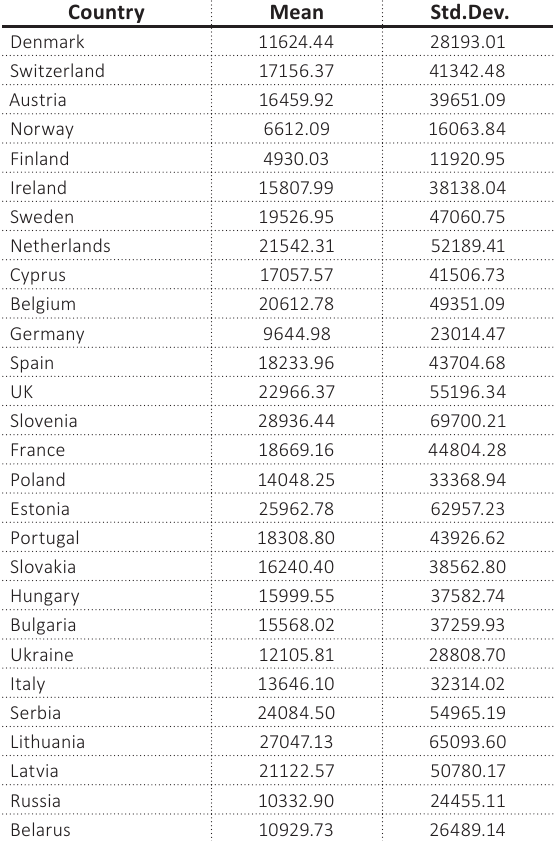
Table 3. Euclidean distances between clusters